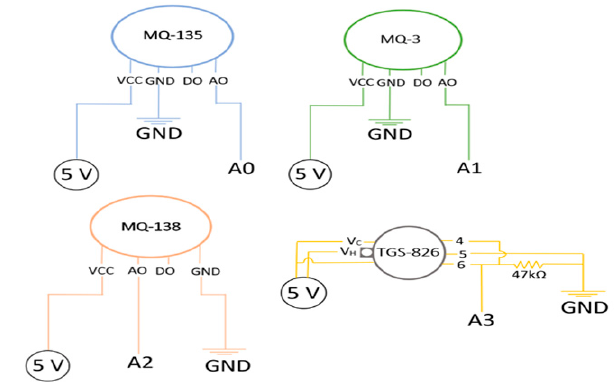
Figure A1. Schema with connections for the four gas sensors.